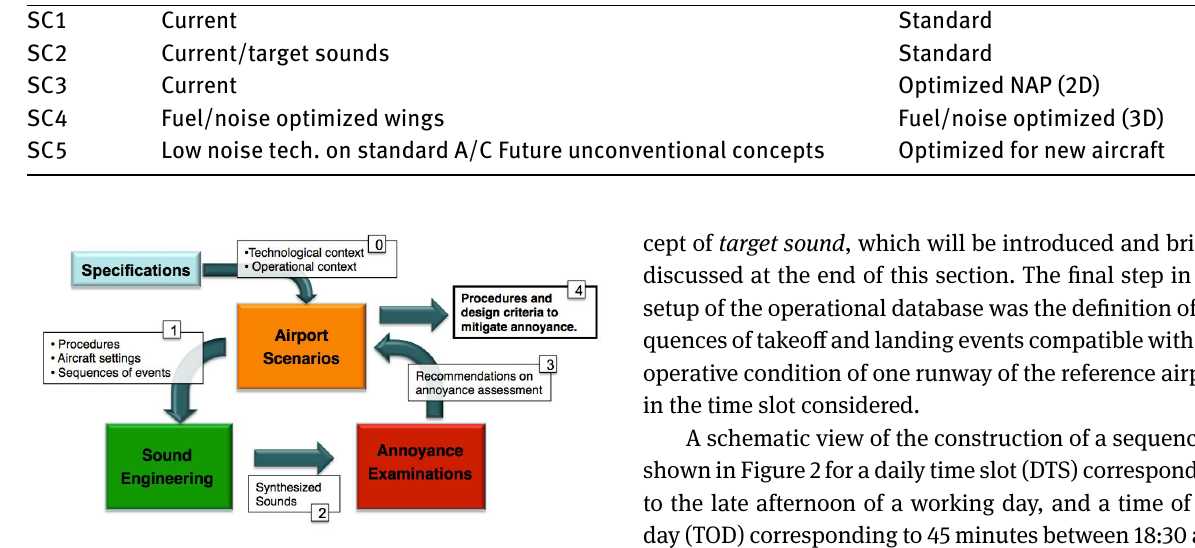
Figure 1: Schematic view of COSMA workflow.